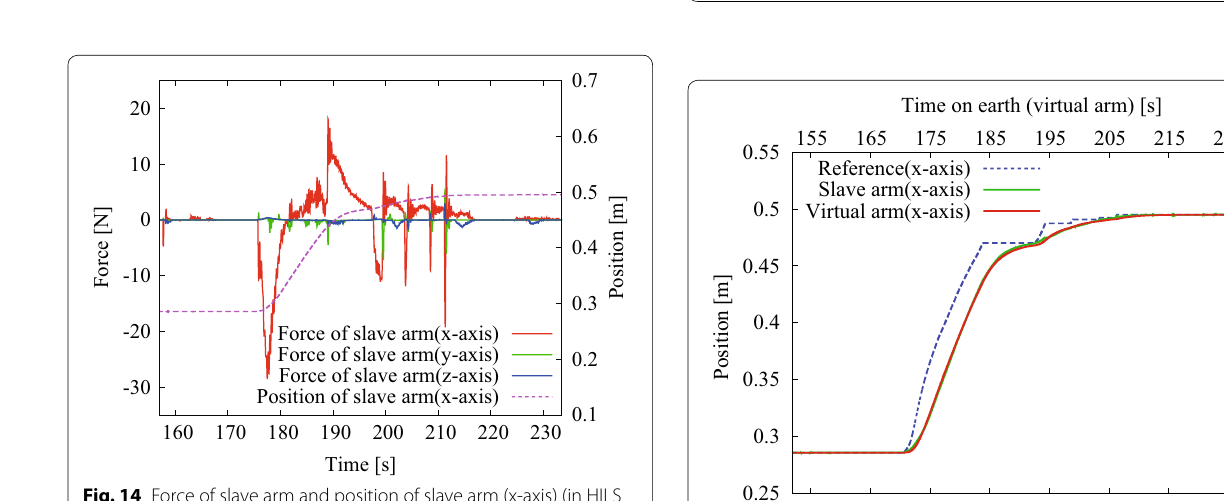
Fig. 16 Force of slave arm and virtual arm (x-axis) (in HILS 2)